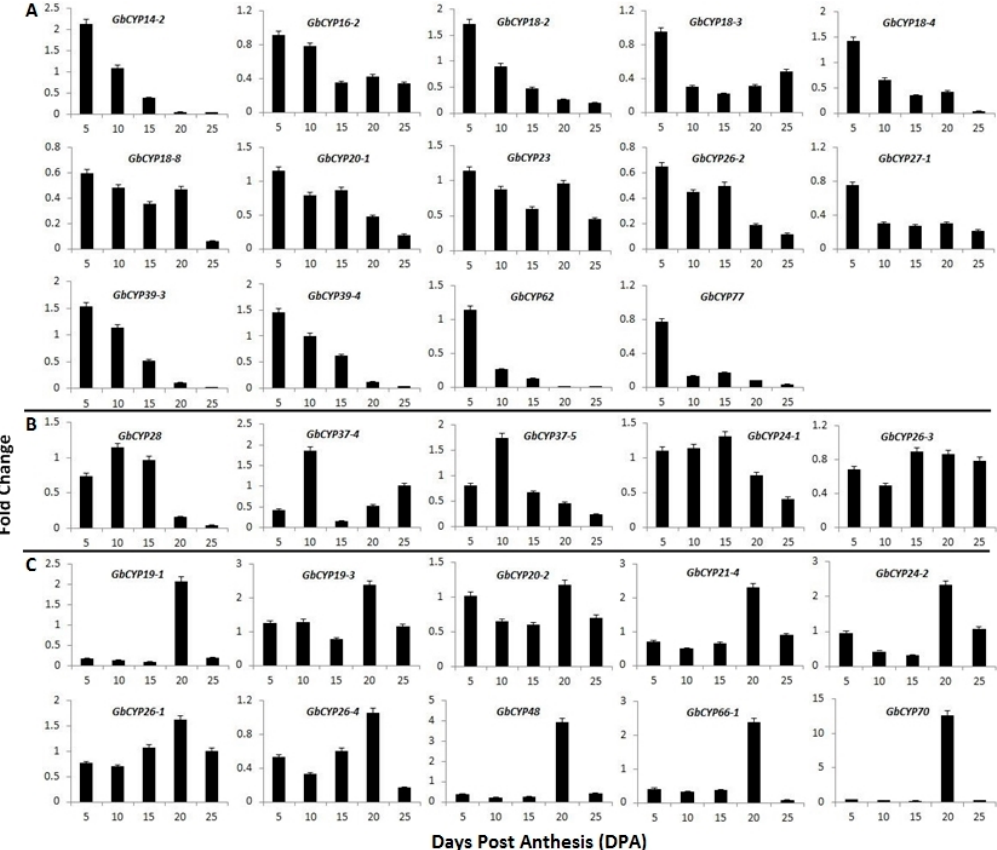
Figure 8. Expression patterns of 29 G. barbadense CYP genes during fibre development based on qRT-PCR. ( A ) Genes that were highly expressed at 5 DPA. ( B ) Genes that were highly expressed at 10 and 15 DPA. ( C ) Genes that were highly expressed at 20 DPA. GbUBQ7 was used as an internal reference to normalise the expression data. Error bars were calculated from the difference in the expression patterns of three biological replicates. The details of the primer sequences are listed in Additional File 11: Table S7.